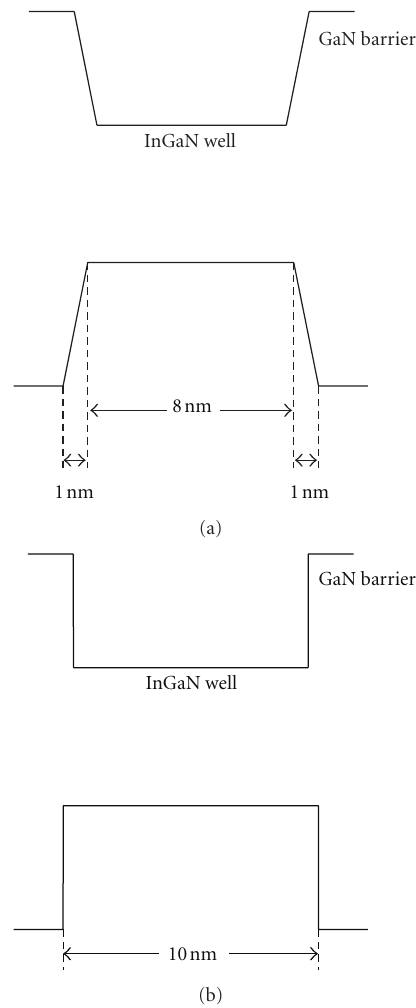
Figure 1: Schematic band diagrams for (a) sample A (trapezoidal well) and (b) sample B (rectangular